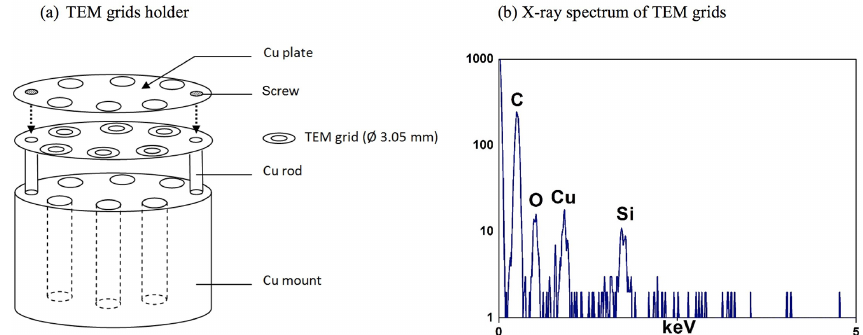
Figure 3. Homemade sample holder for TEM grid samples in SEM/EDX measurements and a typical X-ray spectrum of the TEM